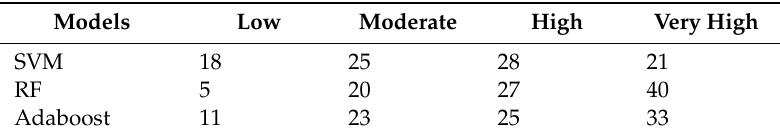
Table 3. The number of surface soil erosion points in di ff erent classes in each model.